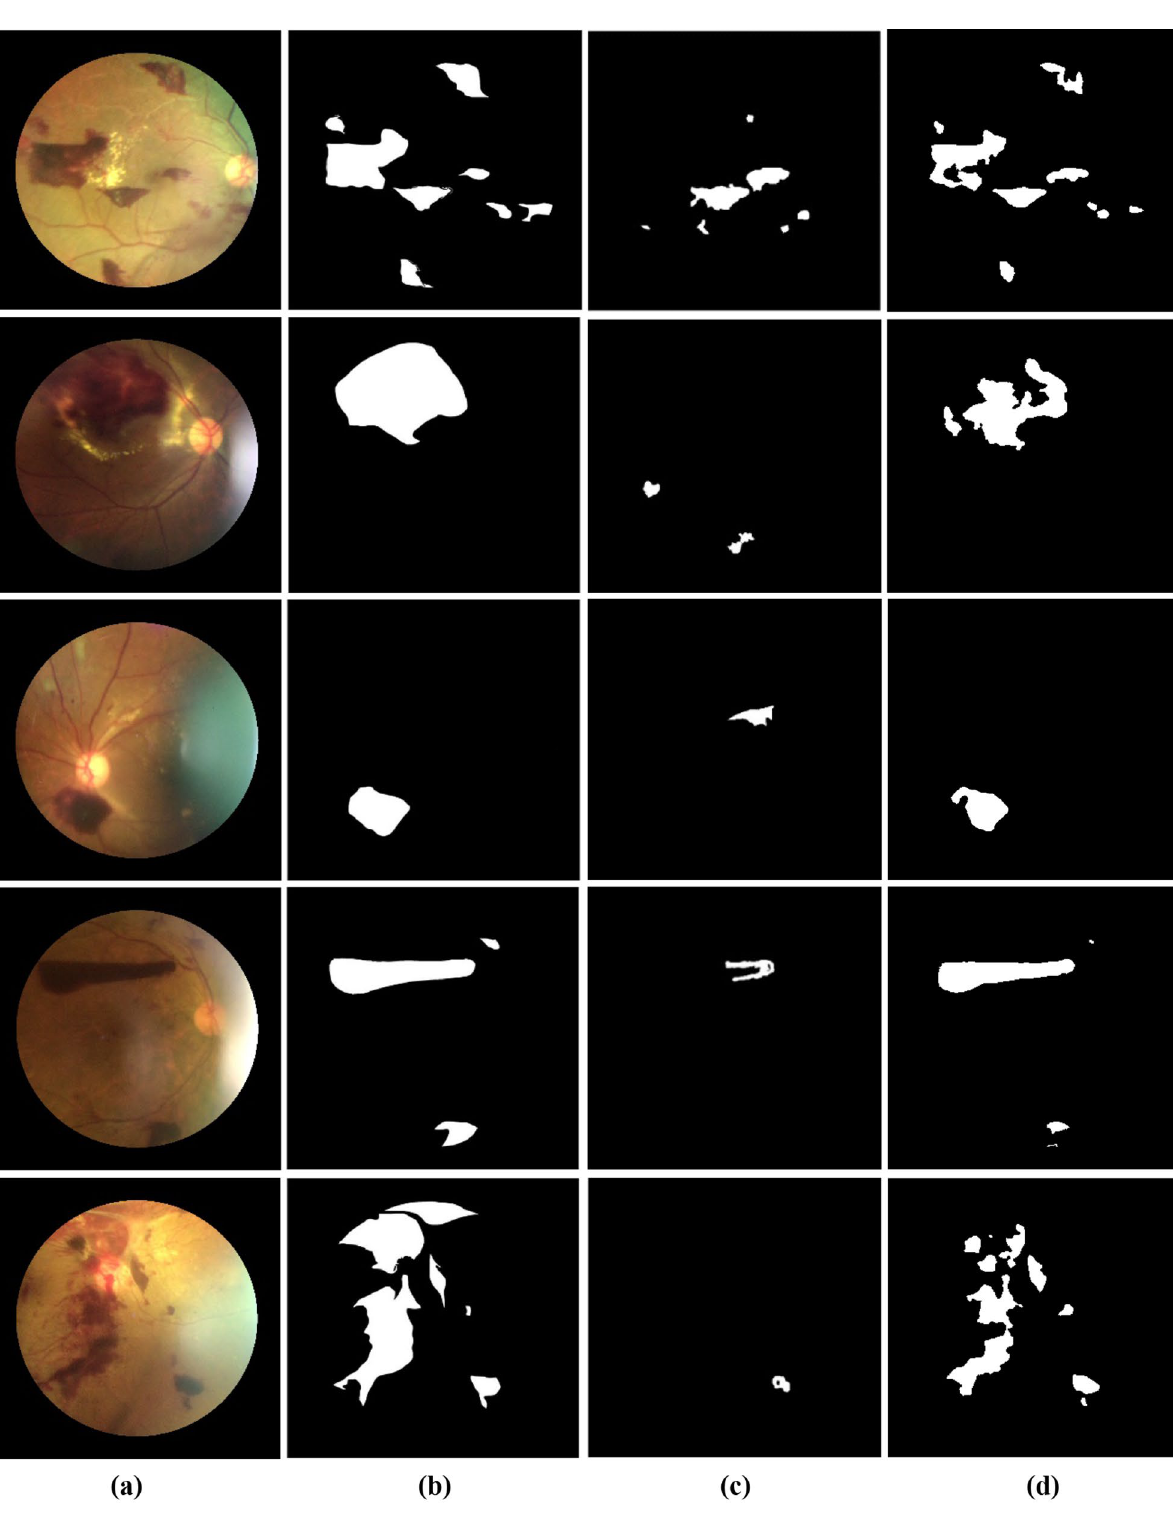
Figure 4. Hemorrhage segmentation comparison: ( a ) original images, ( b ) ground truths, ( c ) DT-HSVE 10 , and ( d ) our proposed method KMMRC-INRG ( d